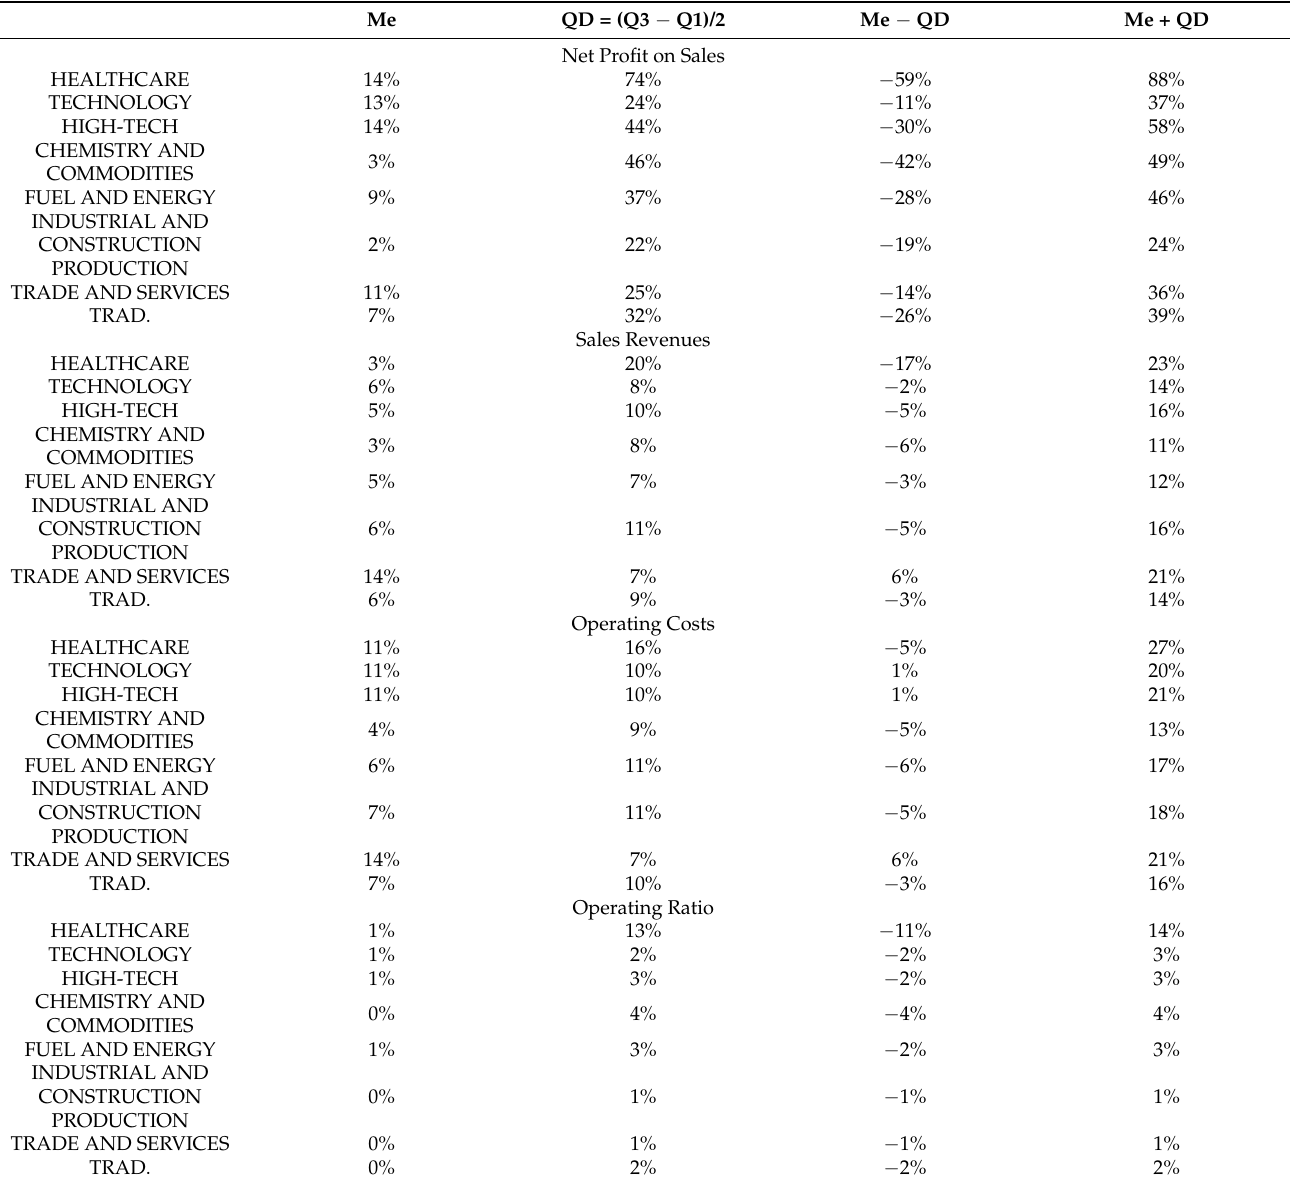
Table A2. Detailed calculation